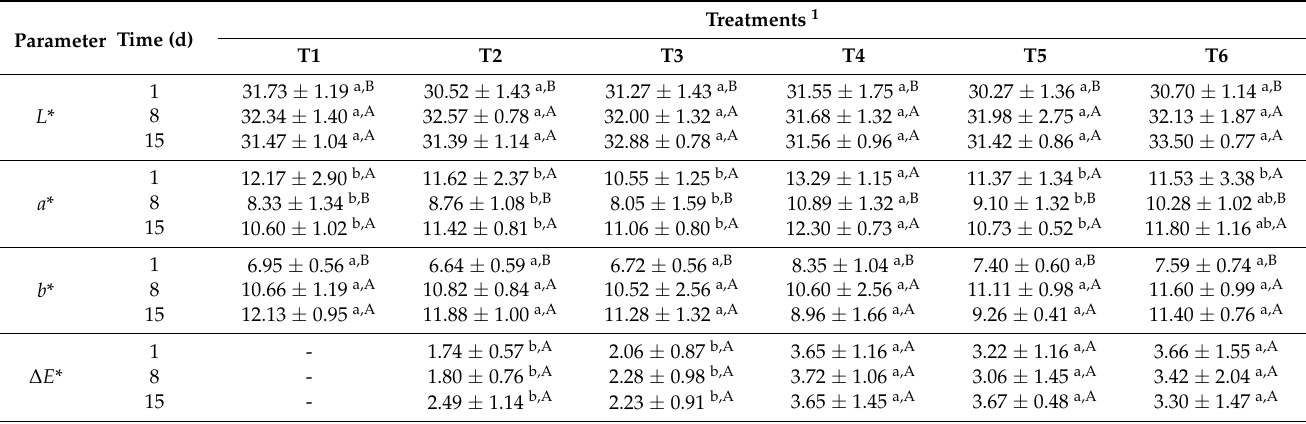
Table 2. Colour parameters (mean ± standard deviation) L*, a * and b * over time in beef hamburgers added to essential oils of rosemary ( Rosmarinus officinalis ), garlic ( Allium sativum ) and chipotle pepper ( Capsicum annum )